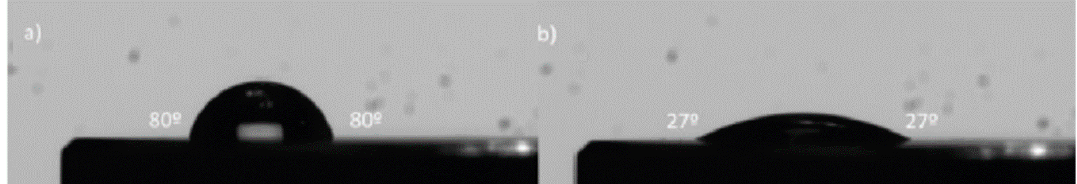
Figure 11. Image of the grade IV NT with a drop of water before ( a ) and after exposure to UV irradiation ( b ).